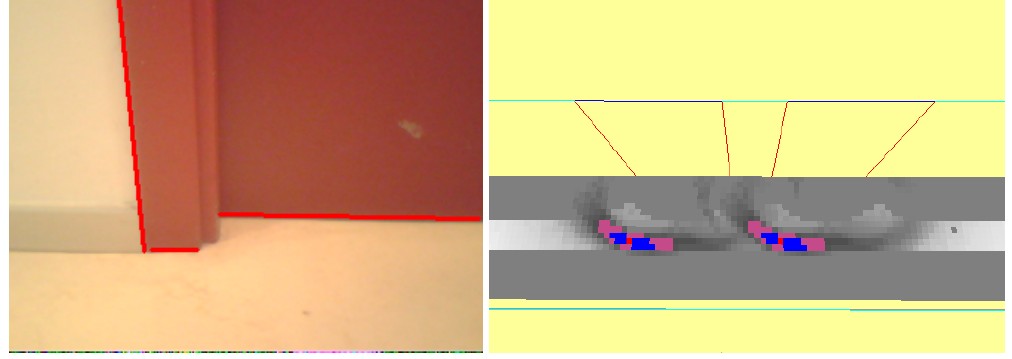
Figure 24. Observed image in front of a door (left) and probabilities calculated for any theta